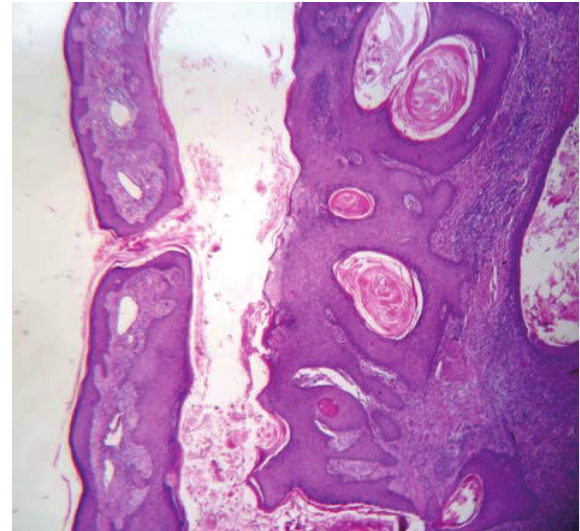
Figure 2: Photomicrograph showing invagination of epidermis and keratin filled crater at the centre [10x H&E].